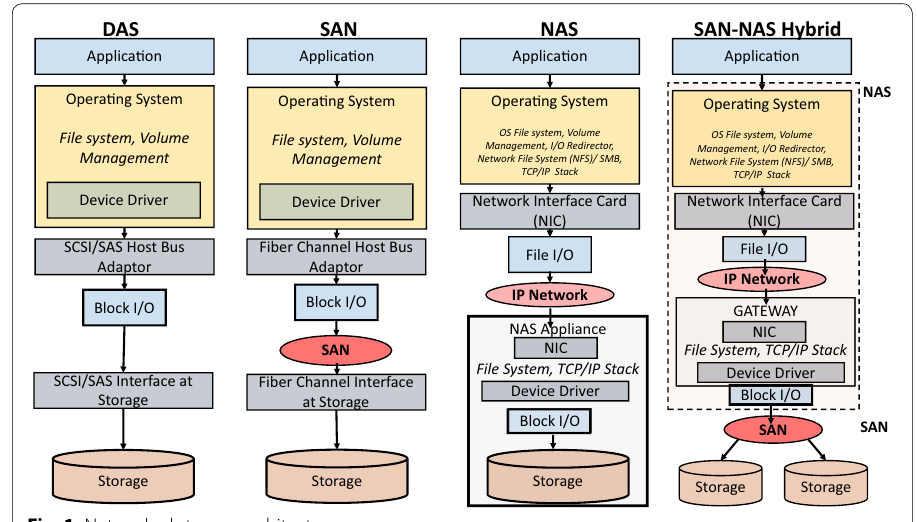
Fig. 1 Networked storage